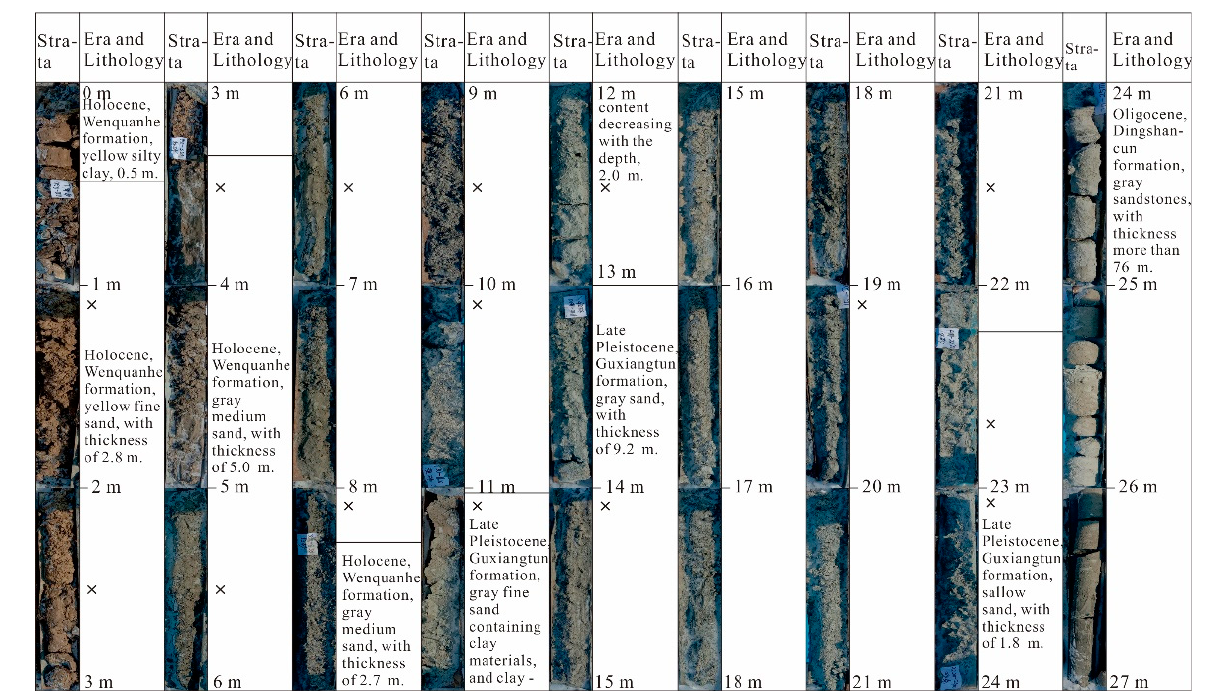
Figure 2. Drill column and sampling location (× is the sample location).